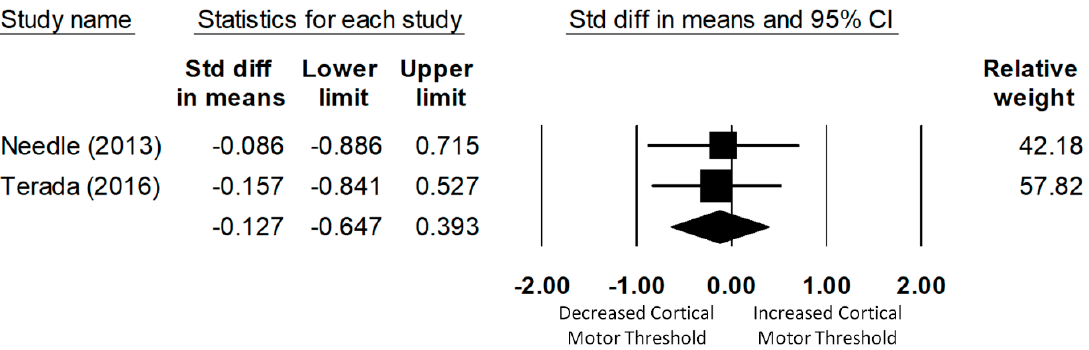
Figure 3. Forest plot illustrating Cohen’s d effect sizes for the fibular longus Hmax/Mmax ratio between groups with and without CAI and their 95% confidence intervals.